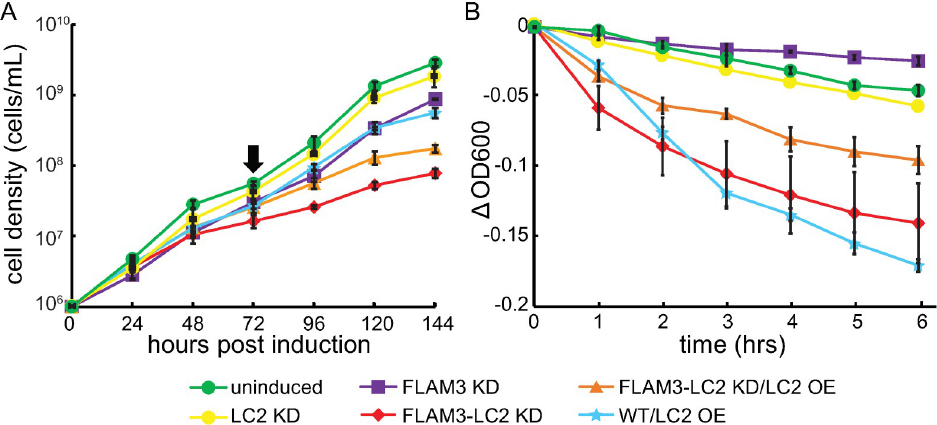
Fig 4. LC2 knocked down cells show growth and motility defects. A . Growth curves of various RNAi knocked down cells and uninduced cells ( green ). At 72 hours post-induction ( black arrow ), we diluted the cells back to the starting cell density (1 × 10 6 cells/mL) and allowed them to grow for another 72 hours. We scaled the cell densities from the diluted culture to reflect the total growth. B . Sedimentation curves of various RNAi knocked down cells and uninduced cells ( green ). In both panels, each data point represents the mean from three independent experiments, and the error bars represent the standard error of the mean (SEM). The legend applies to both panels.